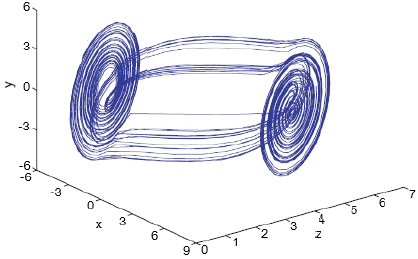
Figure 4. A chaotic attractor with two scrolls. The double-scroll attractor is generated by (2.1) via the series switching technique with the parameter value d = 0.